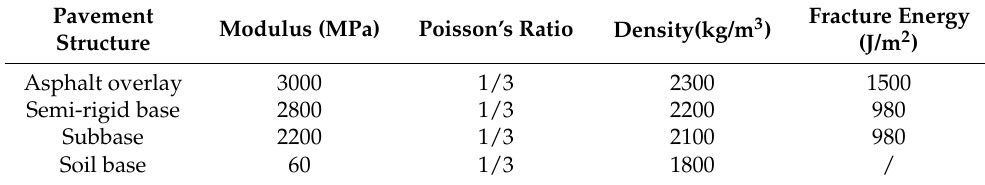
Table 3. Mechanical parameters of pavement